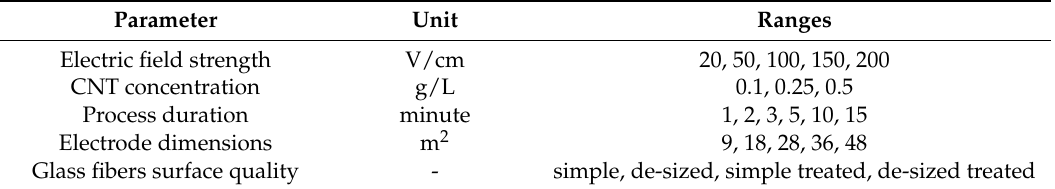
Table 1. Parameters to be evaluated in electrophoretic deposition (EPD) of carbon nanotubes (CNTs) on glass fiber